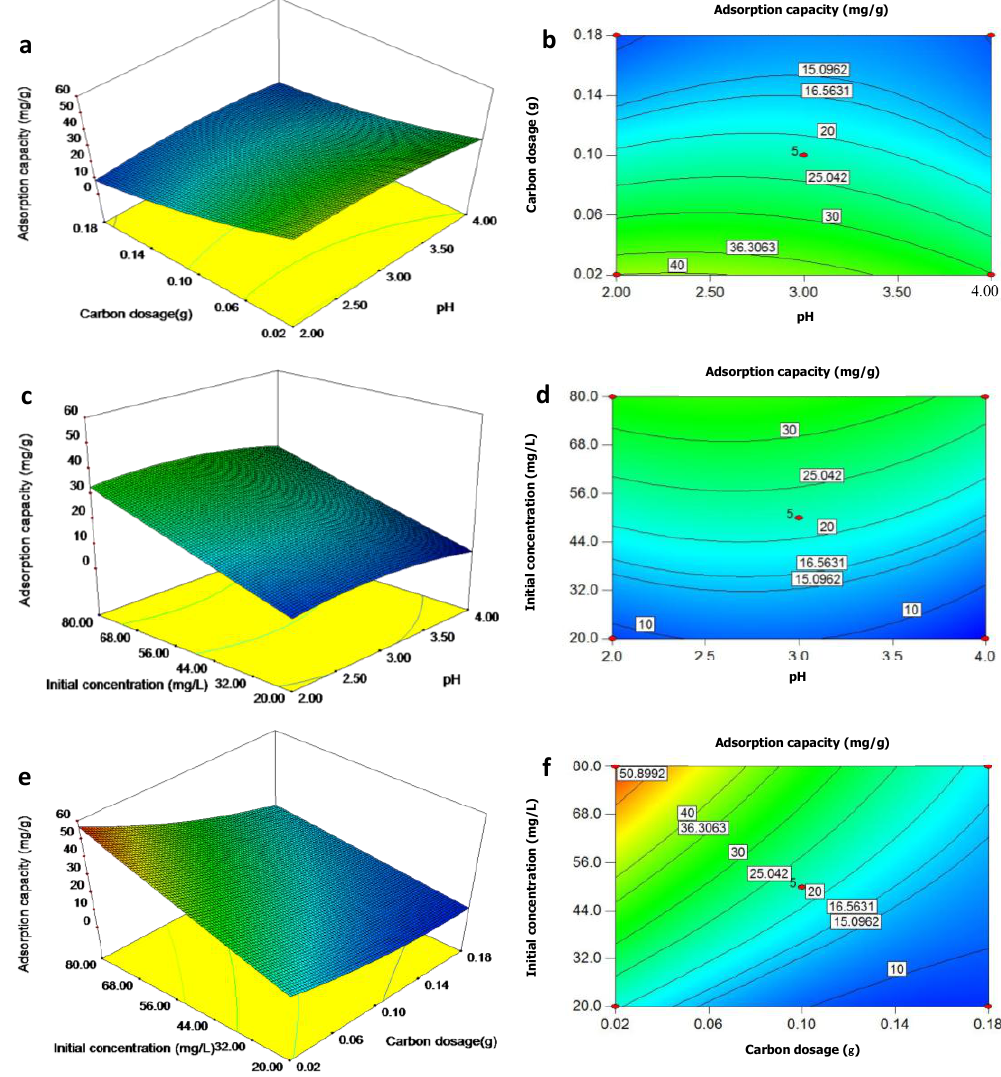
Figure 2. 3D surface mapping and contour plots for combined effects of ( a , b ) pH and carbon dosage ( C 0 = 50 mg/L, t = 120 min, T = 25 ◦ C); ( c , d ) pH and initial concentration ( m/V = 2.0 g/L, t = 120 min, T = 25 ◦ C); and ( e , f ) carbon dosage and initial concentration (pH = 3.0, t = 120 min, T = 25 ◦ C) on Cr adsorption capacity on Typha angustifolia activated